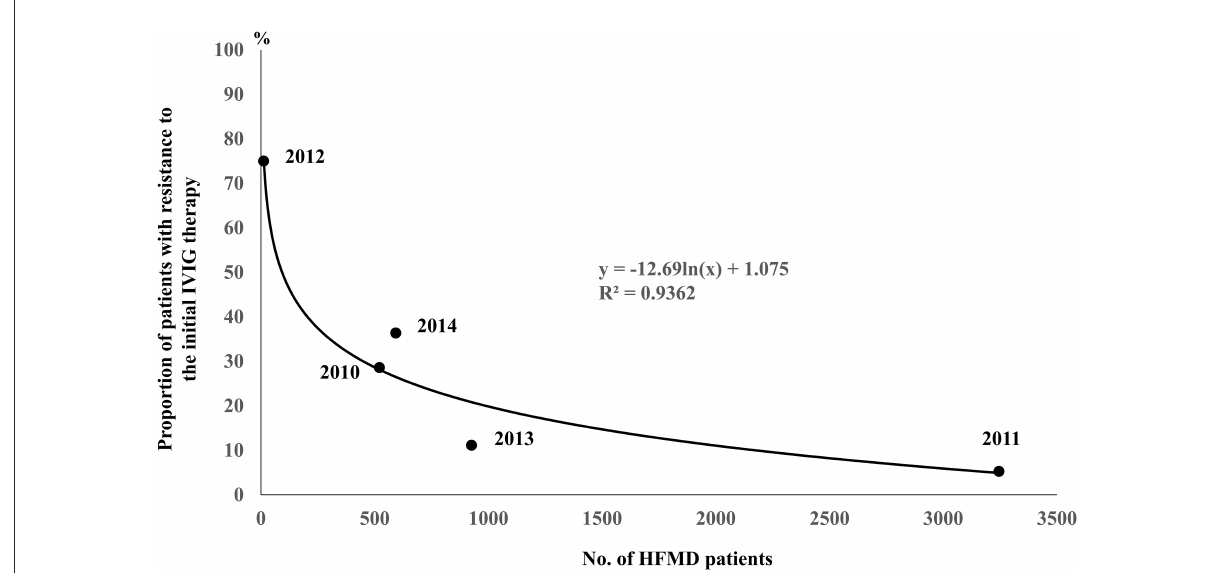
FIGURE2 Correlation between the proportion of patients resistant to the initial IVIG therapy in those who developed KD in August and the total weekly number of HFMD patients reported from the sentinel medical facilities in Kitakyushu City in July. The ratios of the number of KD patients with resistance to the initial IVIG therapy to total number of KD patients in August of each year were 4/14 in 2010, 1/19 in 2011, 3/4 in 2012, 1/9 in 2013 and 4/11 in 2014. The numbers in the brackets indicate the numbers of total KD patients (left) and those with resistance to the initial IVIG therapy